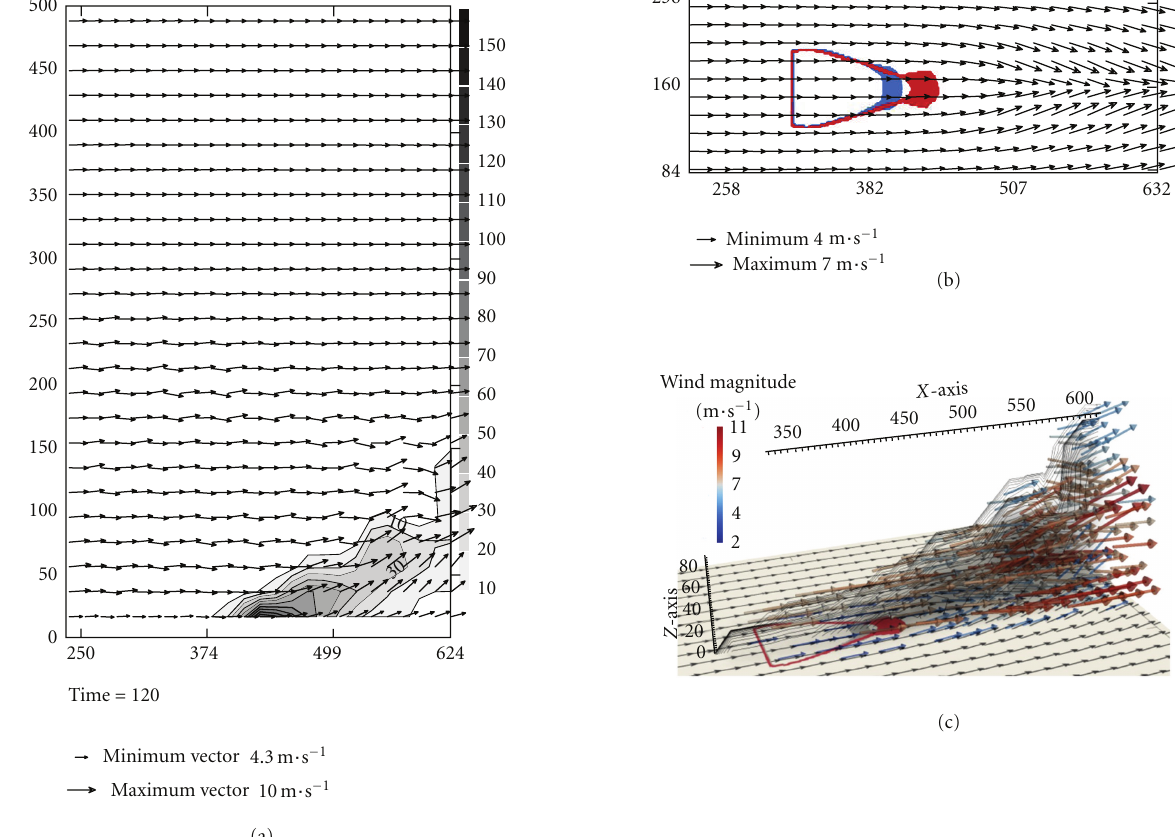
Figure 3: FLAT (a) Horizontal section ( x/y ) at Z = 10 m, fire lines after 120 seconds for the coupled (red) and noncoupled (grey) simulations. Arrows denote the wind vectors at ground level for the coupled case. (b) Cross-section ( x/z ) of the coupled case at Y = 160 m, shading represents concentration of the injected passive tracer. (c) 3d wind field and passive tracer concentration isocontours.